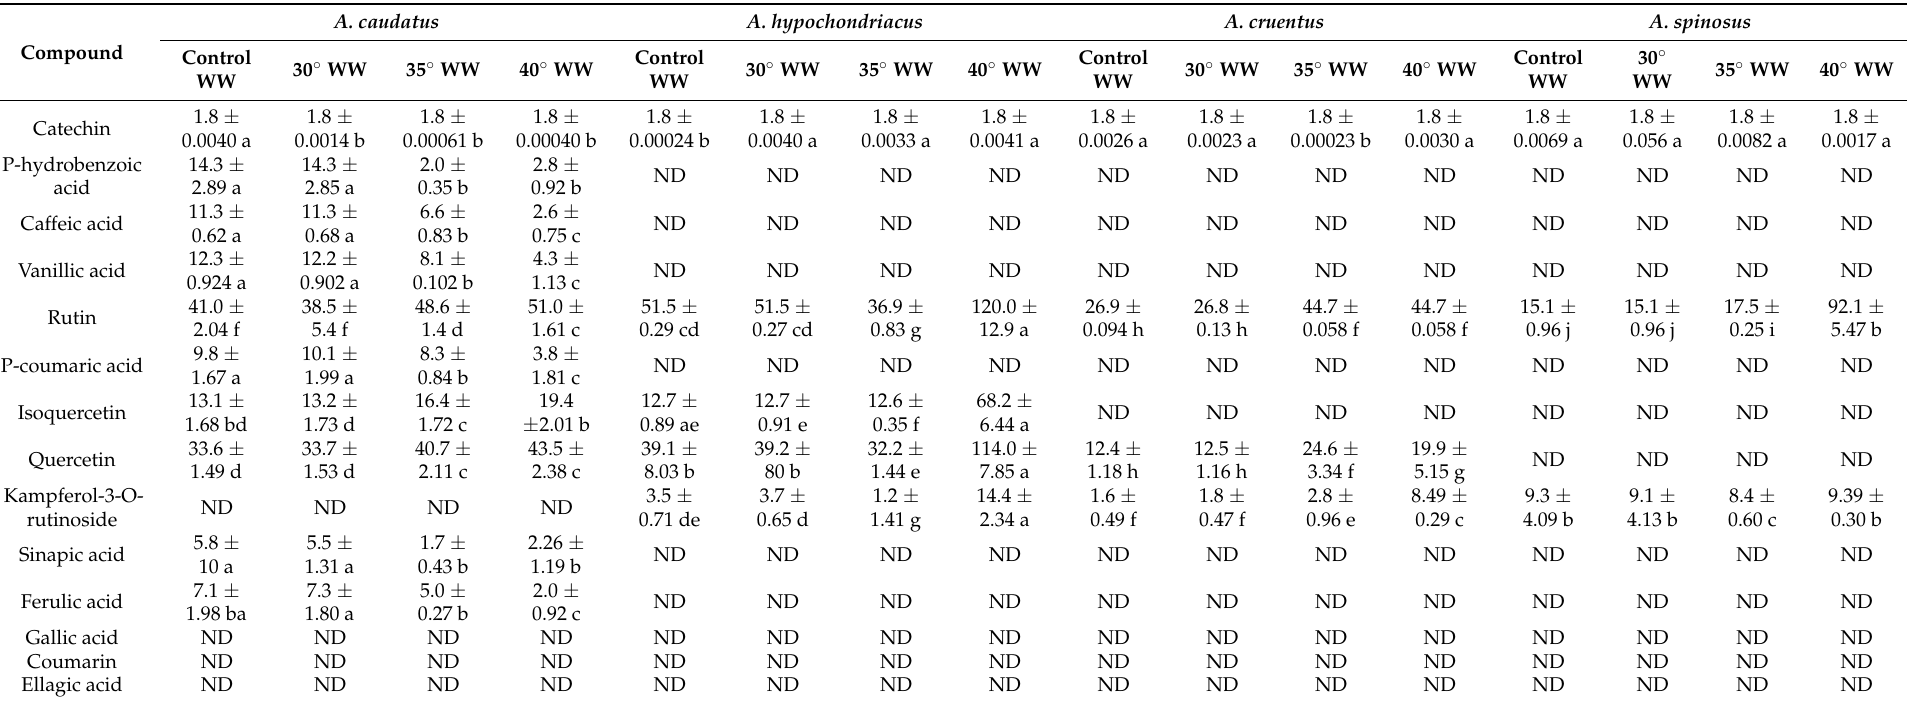
Table 2. Individual phenolic and flavonoids compounds contents detected MeOH leaves extracts of Amaranthus species treated with different temperature regimes under WW condition ( µ g/g DW). ND (not detected). Data are shown as mean ± standard deviation and different letters in the same row indicate significant differences ( p ≤